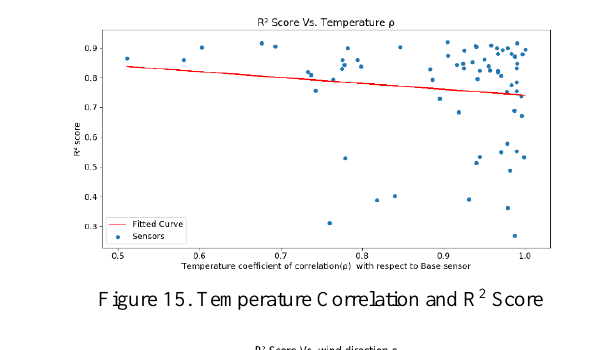
Figure 15. Temperature Correlation and R 2 Score